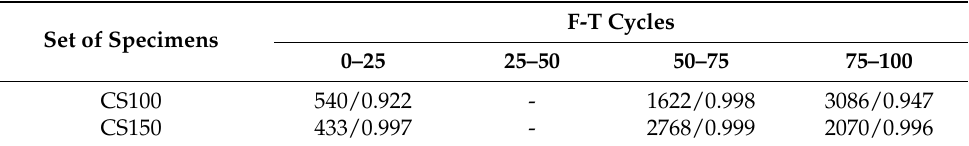
Table 4. Slope of the line interpolated with cumulative AE counts during F-T cycles (the number after the slash represents the coefficient of determination R 2 ).